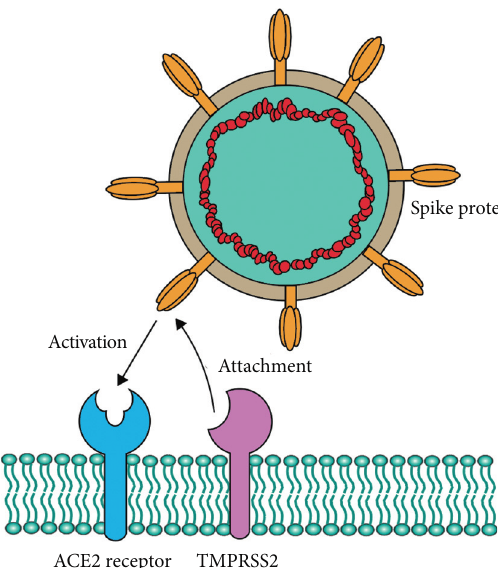
Figure 1: TMPRSS2 plays an important role in activation and conformational change of SARS-CoV-2 spike protein, which leads to the ACE2 receptor binding of the